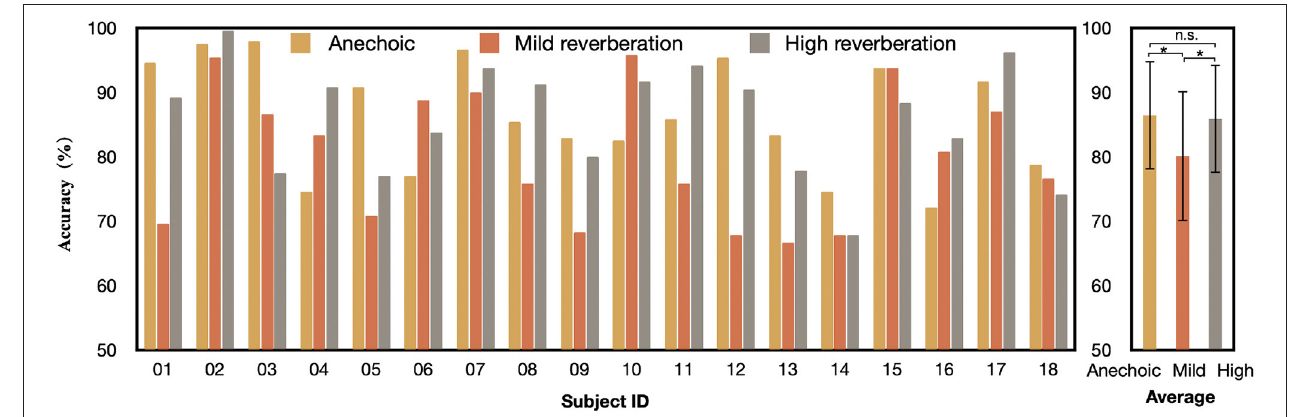
FIGURE 6 | Auditory attention detection accuracy of the CMAA model across all subjects under three different acoustic conditions with the 2-s decision window. Significance was calculated using paired t -test (* p <0.05, n.s., no significance).